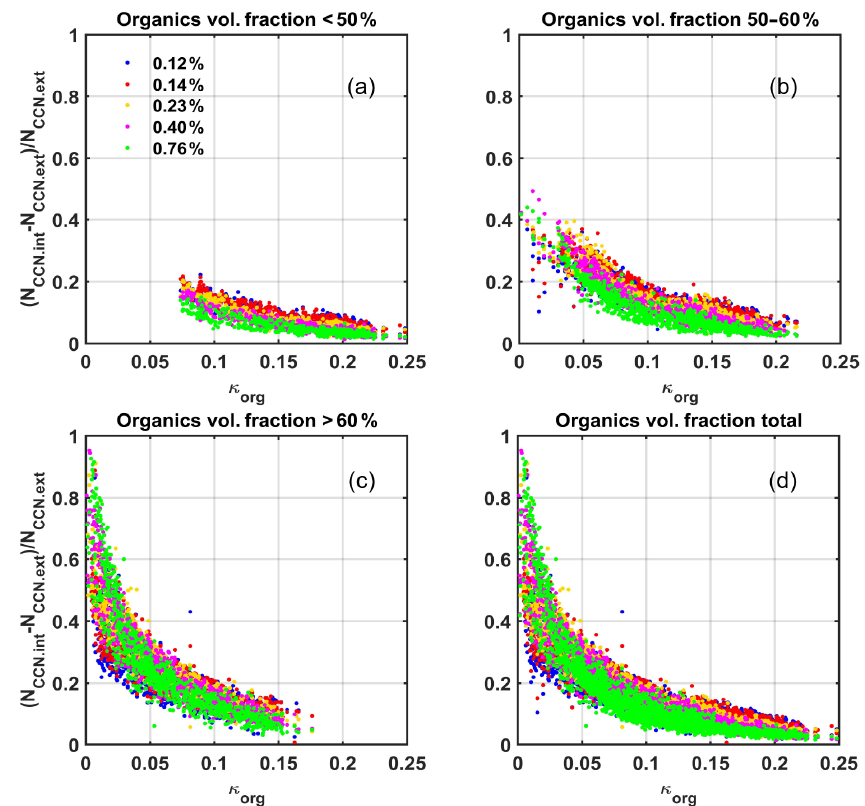
Figure 9. Relative deviations between N CCN predicted under the assumptions of internal (INT–BK) and external (EXT–BK) mixtures [(N CCN · INT–BK − N CCN · EXT–BK) ( N CCN · EXT–BK) − 1 ] as a function of κ org with organic volume fractions of < 50 (a) , 50–60 (b) , > 60% (c) using all observed data points (d) . The different colors represent different supersaturation levels (see inset in (a)